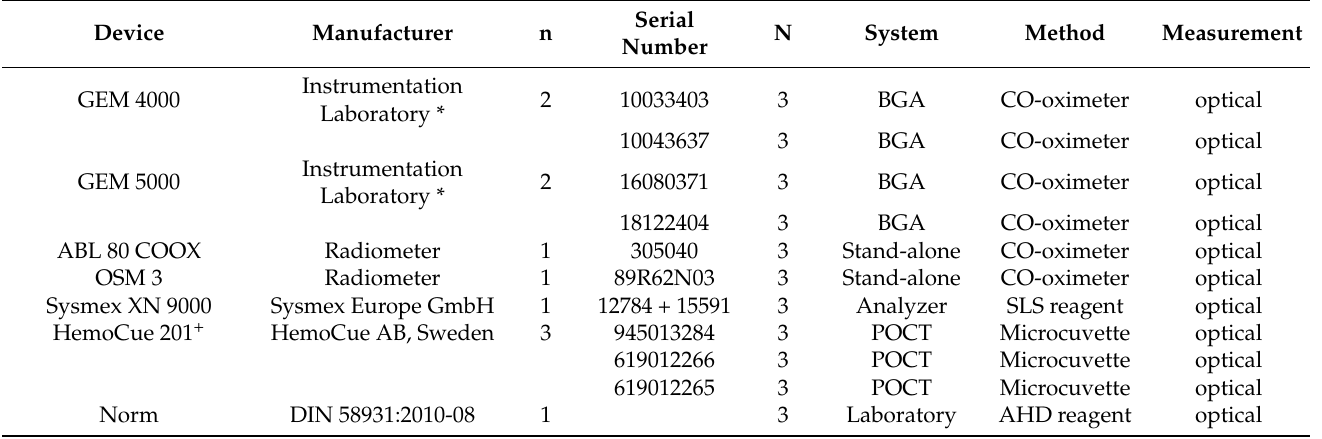
Table 1. Specifications for the test devices. BGA = blood gas analyzer, n = number of devices or methods, N = number of measurements per sample, POCT = point of care testing, SLS = sodium lauryl sulfate reagent, AHD = alkaline hematin detergent (AHD575), DIN = German Institute for Standardization, * Werfen